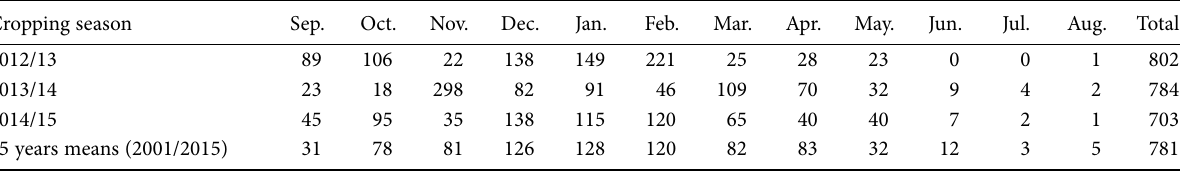
Table 2. Monthly rainfall (mm) recorded during the 2012/2013, 2013/14 and 2014/15 cropping seasons at Fernana, Tunisia. Cropping